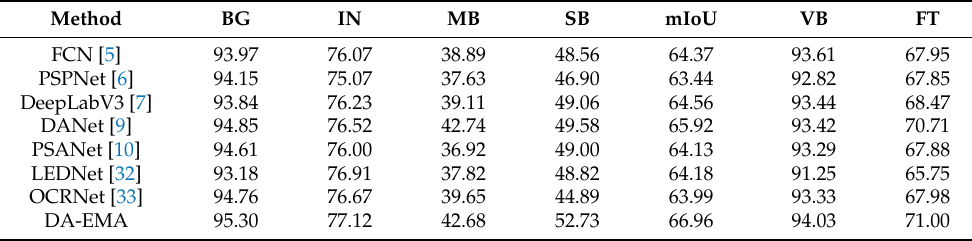
Table 6. Comparison of the proposed DA-EMA and other semantic segmentation models.